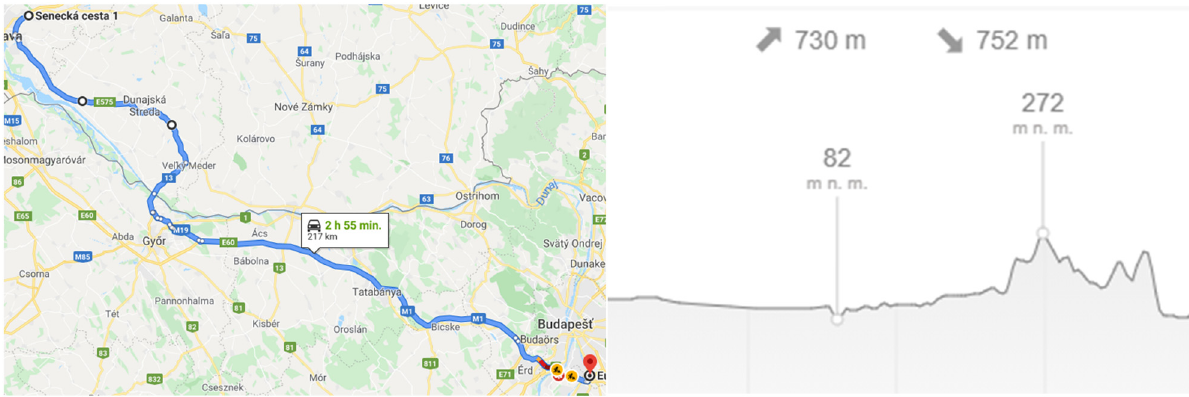
Figure 2: Transport route and route altitude pro fi le Ivanka pri Dunaji – Budape šť [ 46 ]